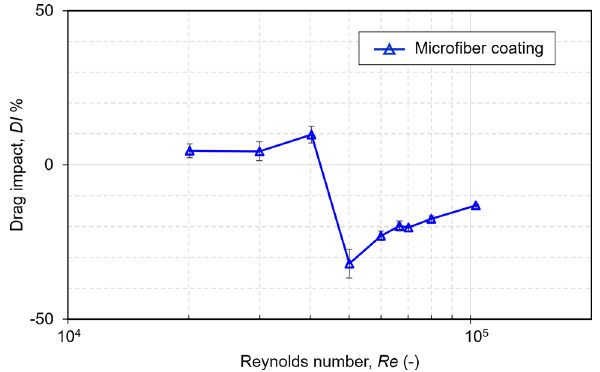
Figure 6. Drag impact DI related to the Reynolds Number Re